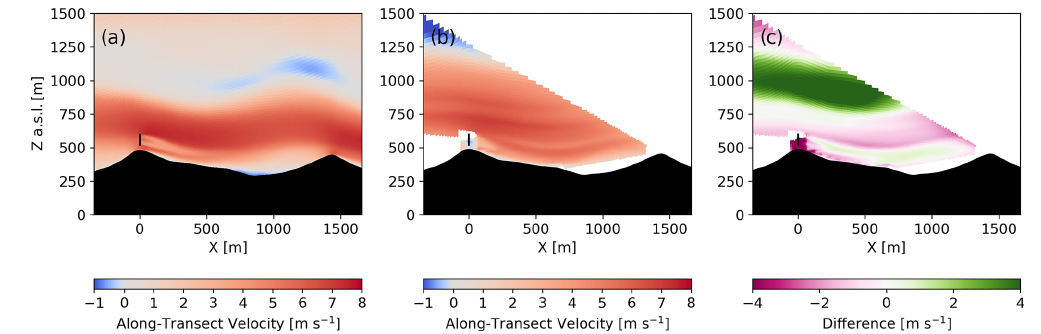
Figure 5. Transect of 1h time-averaged along-transect velocity for the (a) model and (b) DLR lidar during the stable case study with panel (c) as the difference between the DLR lidar and the model. The transects are aligned with the wake transect in Fig.